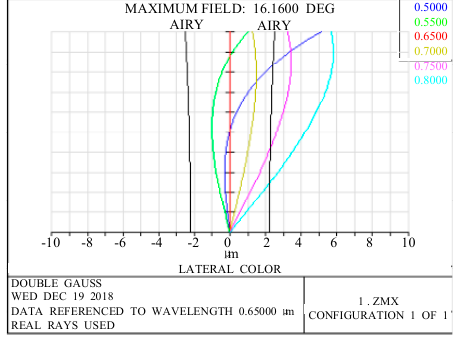
Figure 4. Lateral color of the optical system.